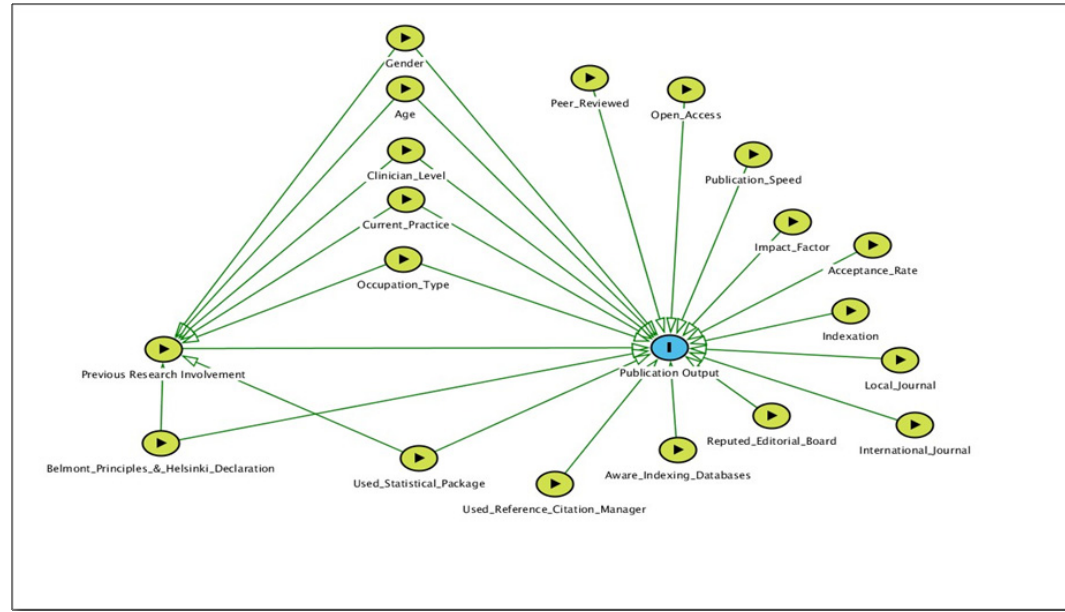
Figure 1. A Directed Acyclic Graph (DAG) of the factors of interest in the analysis. The outcome variable is identified as a blue oval with a black frame; exposures are identified as a green oval with a black frame.